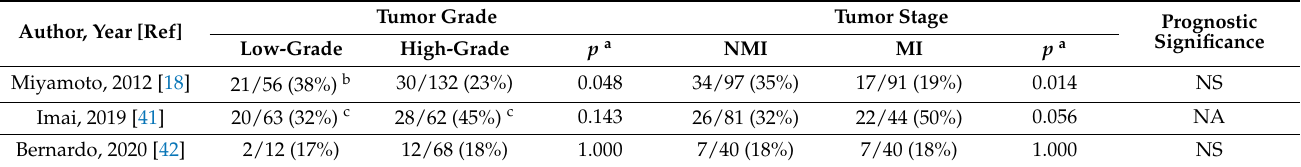
Table 2. Immunoreactivity for ER α in low-grade vs. high-grade and NMI vs. MI bladder cancers and its prognostic significance.